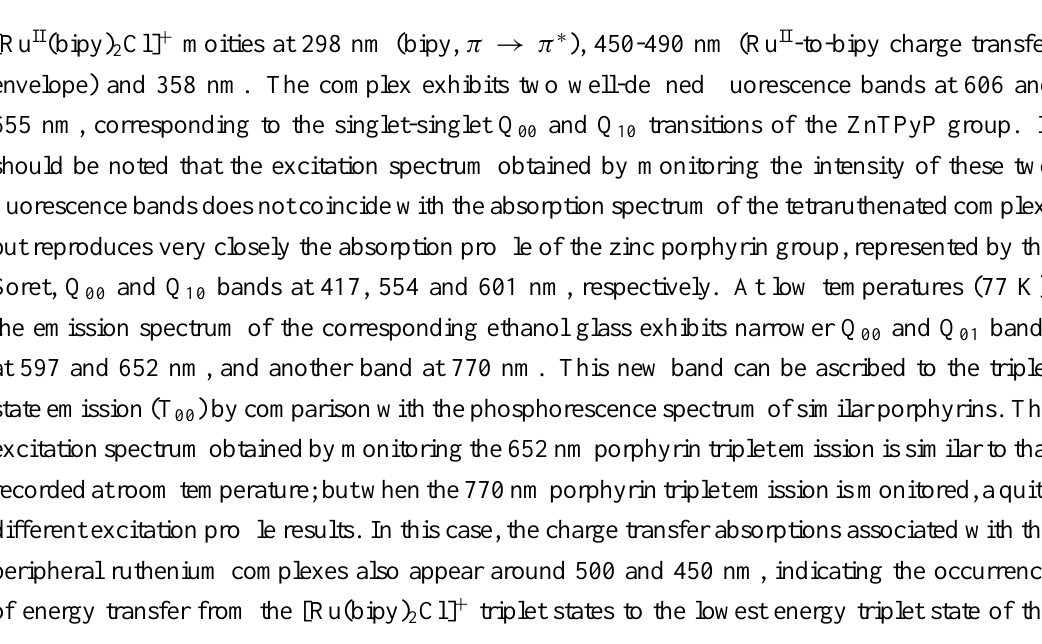
Fig. 7 – Structural representation of [TPyP{Ru(bipy) 2 Cl} 4 ] 4 +